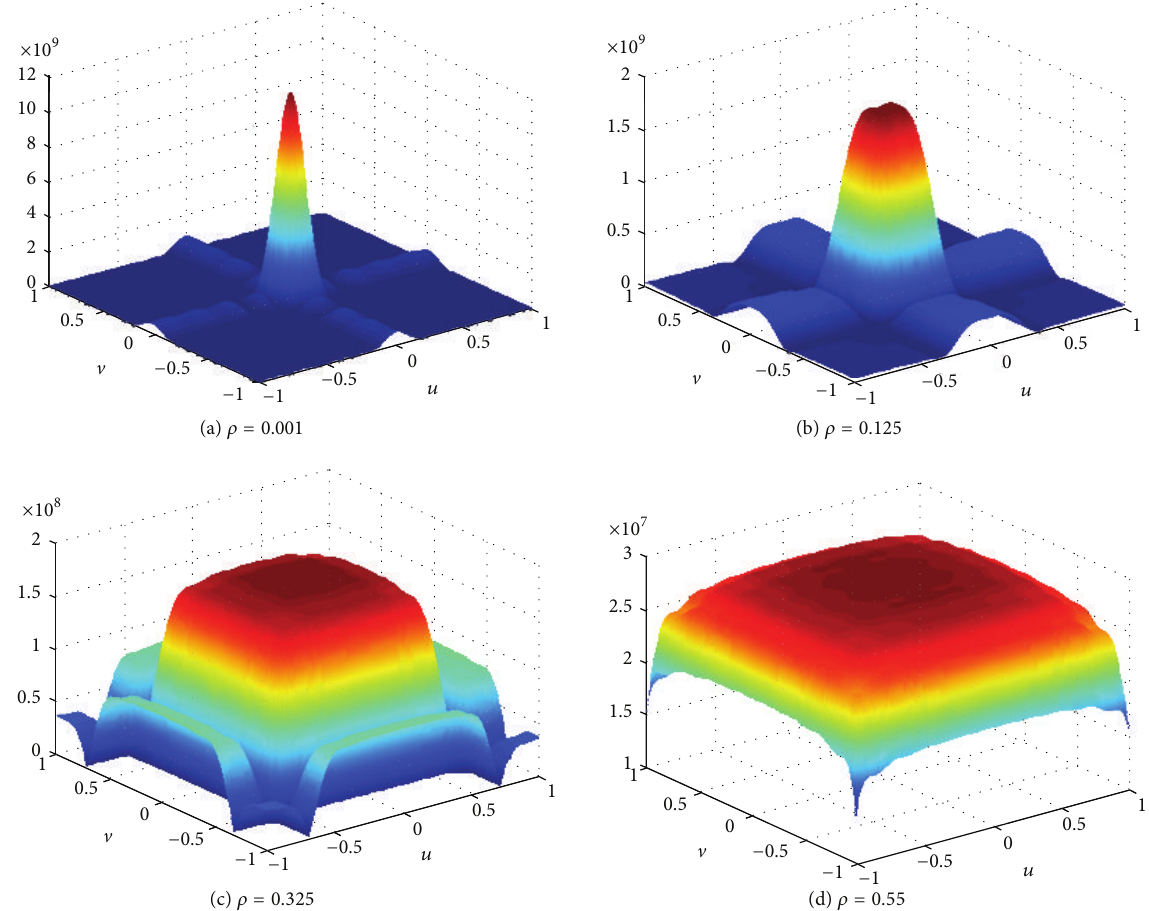
Figure 21: Transmit beam patterns based on synthesis of subarray transmitted signal. Table 3: PSLs of total pattern for different radar models (dB). Radar